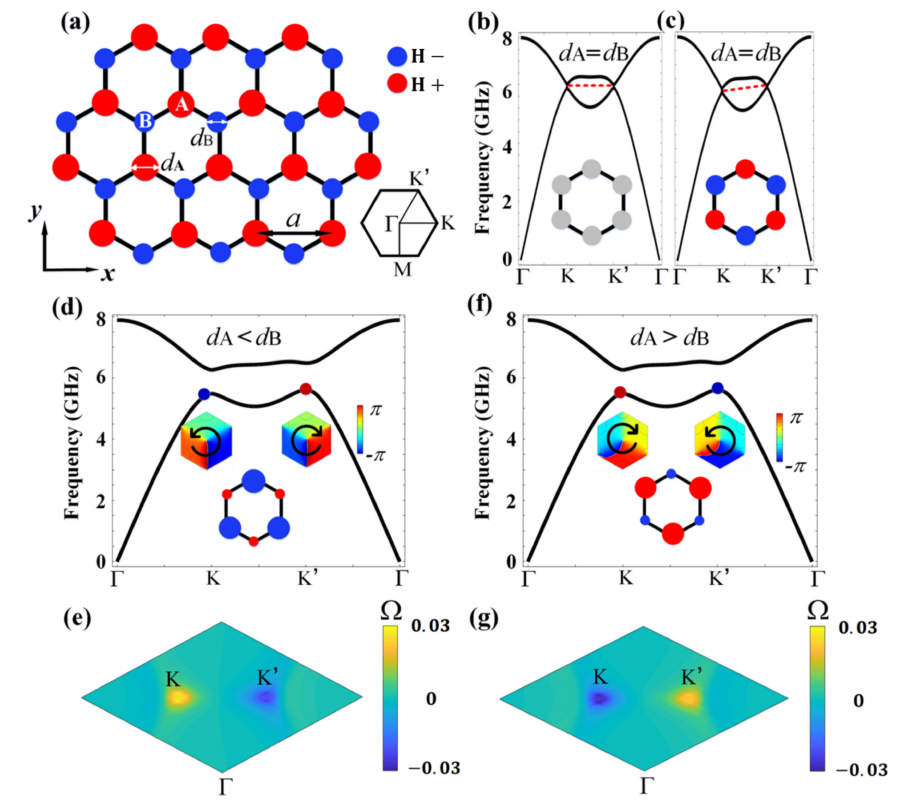
Figure 1. The proposed 2D PC with biased magnetic fields and broken inversion symmetry. ( a ) Sch ematic of the PC, which is a honeycomb lattice of sublattices A and B, with d A ( d B ) the radius of A